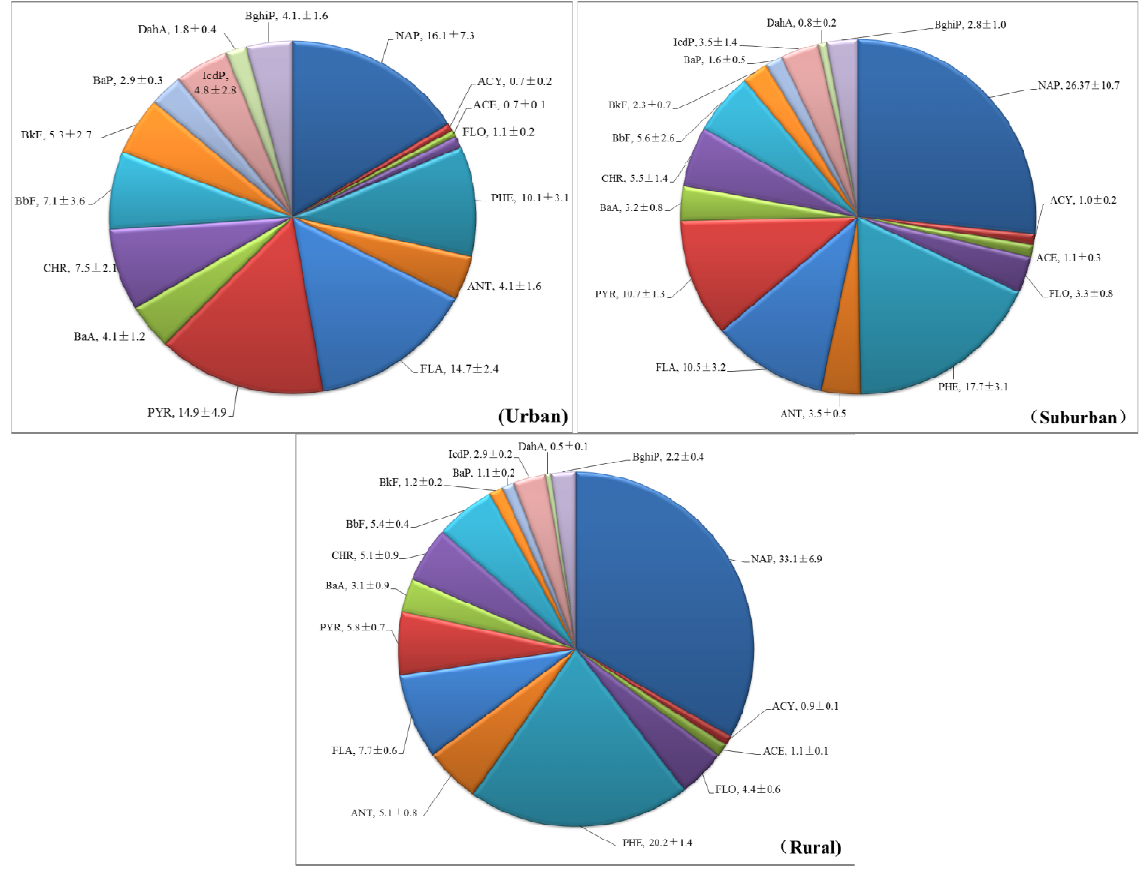
Figure 2. Contribution of the individual PAH compounds to the total PAHs in forest soils along the urban–suburban–rural transect